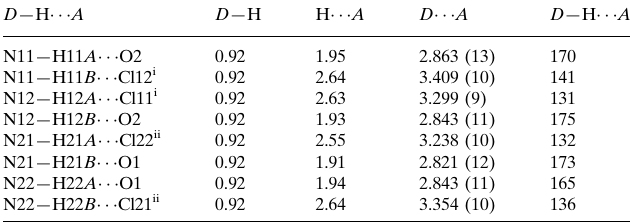
Hydrogen-bond geometry (A˚ , (cid:3)